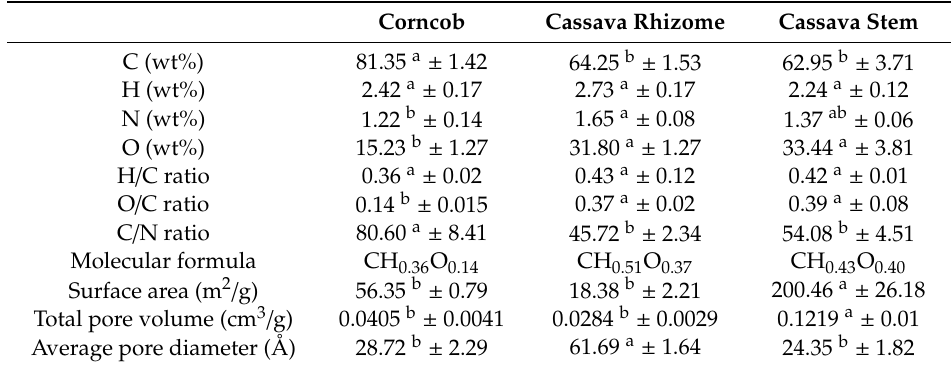
Table 2. Properties of biochar